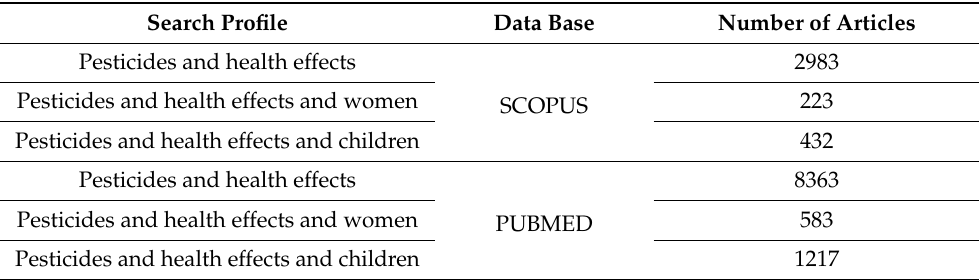
Table 1. Search in databases: different number of articles present in the two main data bases used for this review and included in the table that contains information relating pesticides and health effects in women and